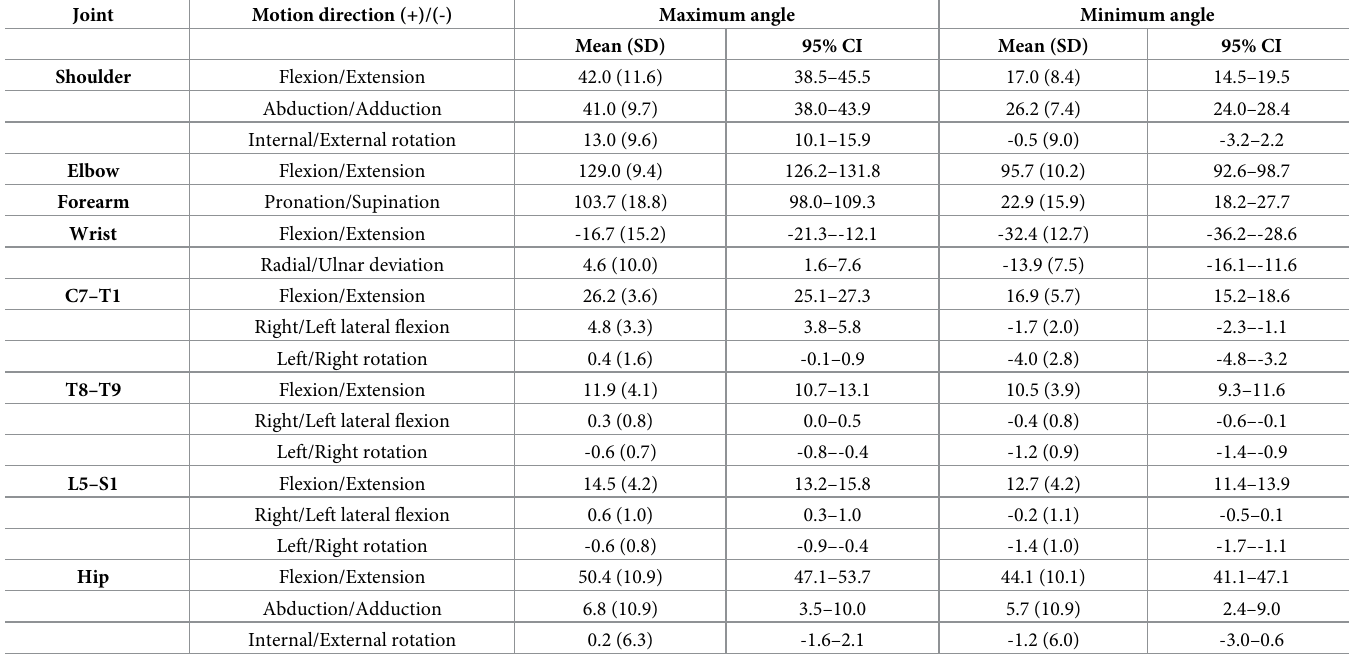
Table 1. Whole-body joint angles across the four eating